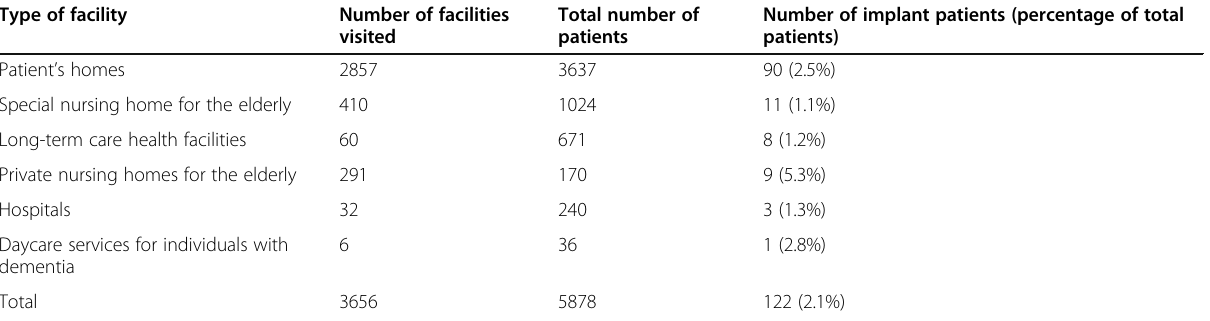
Table 2 Types of facilities visited for domiciliary dental care in the Tokyo metropolitan area and the number of implant patients in these facilities